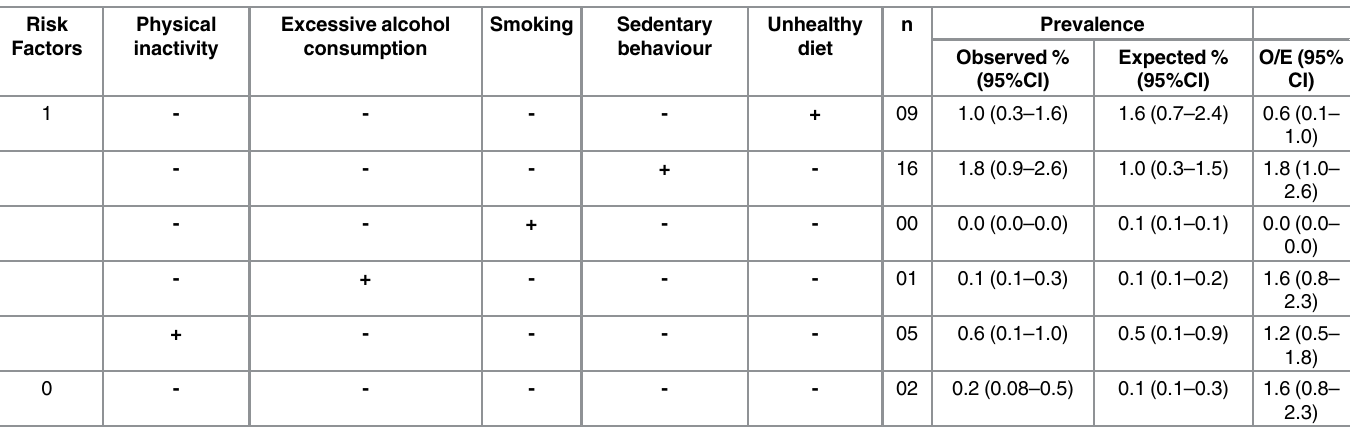
Associations between the dependent variable "clustering of risk factors" and both demo- graphic and economic variables were analysed by multinomial logistic regression, with estima- tions of the odds ratio (OR) and respective confidence intervals (CI 95%). The reference category was "no risk factor"; however, due to the low frequency of individuals in this category (0.2%), it was combined with the category "one risk factor" (3.7%). Therefore, "none or one risk factor" was considered the reference (3.9%). The adjusted analysis controlled for all indepen- dent variables of the study (sex, age, skin colour, school shift and economic level) (Table 4). Moreover, binary logistic regression was performed for simultaneous risk factors that had a higher prevalence in this population (6.0% of adolescents had both physical inactivity and unhealthy diet, 10.8% of adolescents had sedentary lifestyle and unhealthy diet, 40.5% had physical inactivity, sedentary behaviour and unhealthy diet, and 17.7% had physical inactivity, excessive alcohol consumption, sedentary behaviour and unhealthy diet), along with the esti- mated OR and respective 95% confidence interval. The adjusted analysis controlled for all inde- pendent variables of the study (sex, age, skin colour, school shift and economic level) (Table 5). We adopted p < 0.05 as the level of significance for all statistical tests, and we used Stata 1